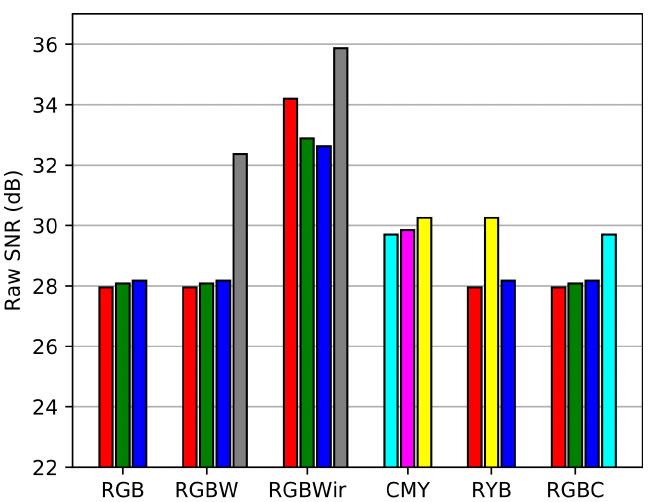
Figure 17. SNR over raw channels of each sensors, the colors code follows the name of the channels.